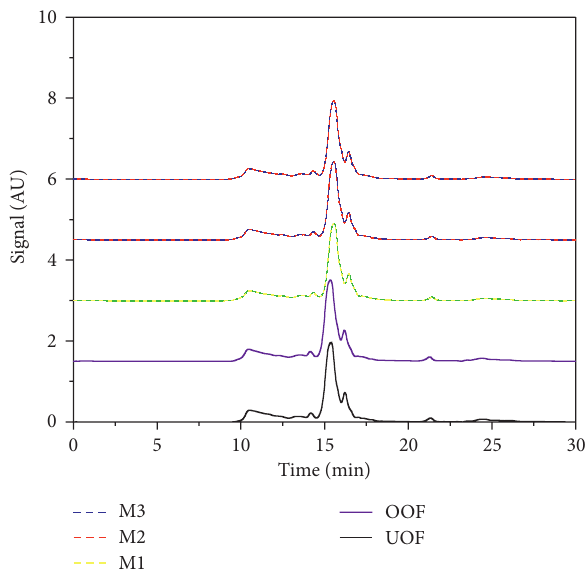
Figure 2: SE-HPLC chromatograms for extractable protein of wheat flour added with different ratios of overozonized wheat flour.